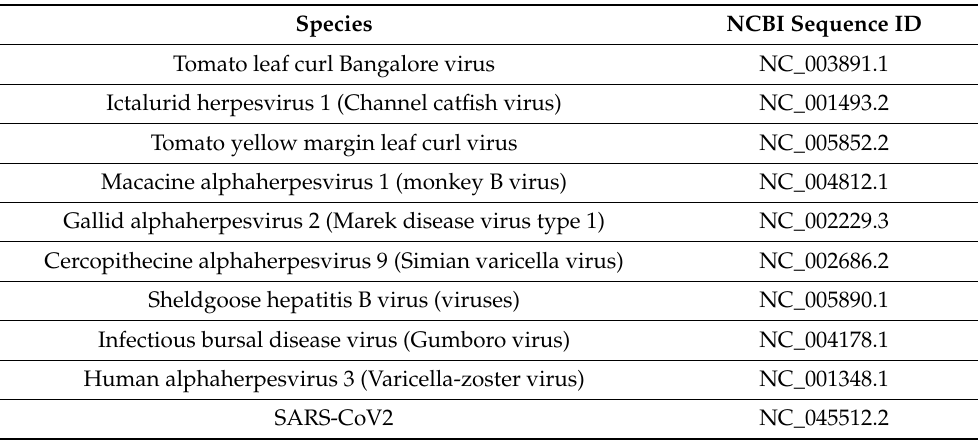
Table A2. Viral genomes and their IDs for NCBI, used to construct artificial mix of viral transcrip- tomes to test how accurate are methods we used for taxonomic identification of reads originated from viral